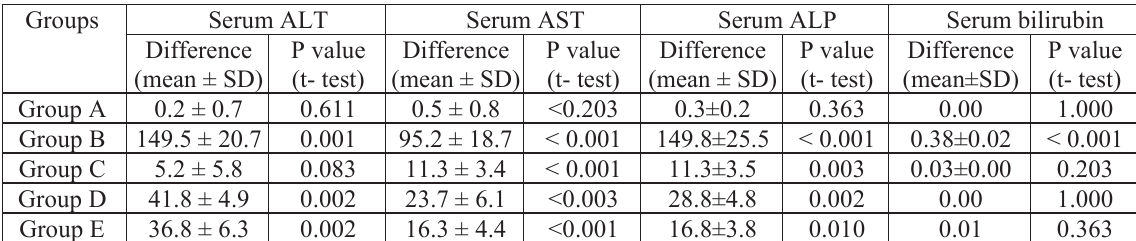
Table-1: Mean ± SD of difference in Serum ALT, AST, ALP (IU/L) and bilirubin (mg/dl) level between day 0 and day 14 (n=6) Group A: Normal Control, Group B: Anti-tuberculous drugs (ATT), Group C: ATT + Whole Ajwa Date, Group D: ATT + Ajwa Date Flesh, Group E: ATT + Ajwa Date Seed